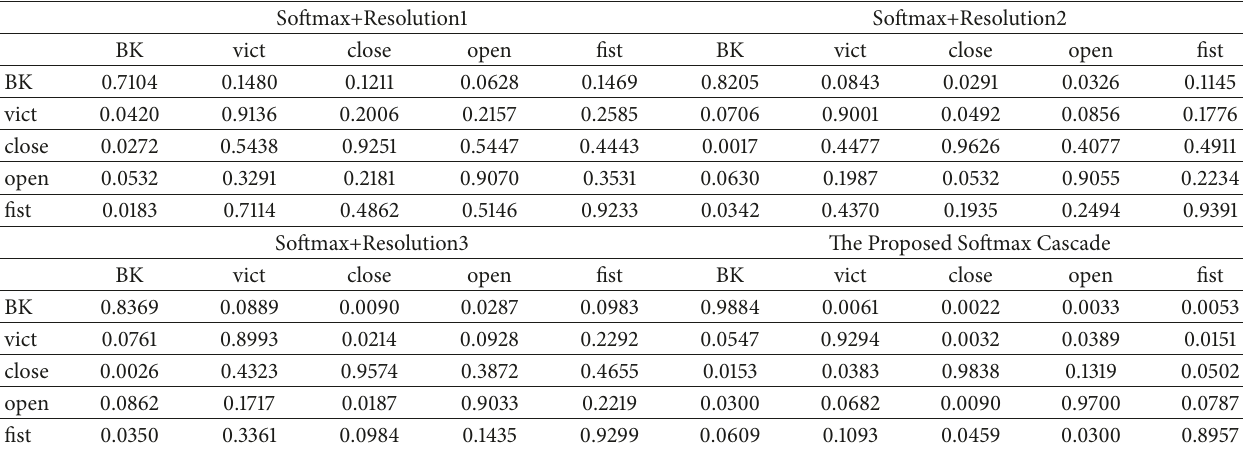
Table 2: The confusion matrices for detection results computed with single-resolution-based softmax detectors and multiresolution-based cascade detector. Note that row elements of matrix do not need to sum to 1 for confusion matrix of detection problem.